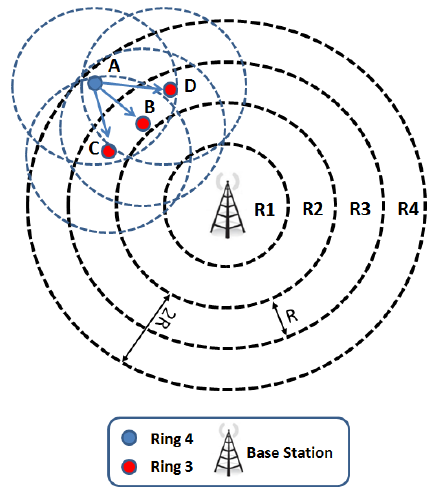
Figure 4. Finding the next hop node in RARZ.